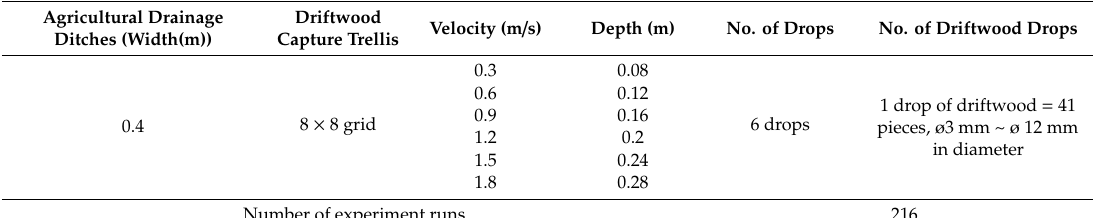
Table 6. Experimental conditions for agricultural drainage ditches.